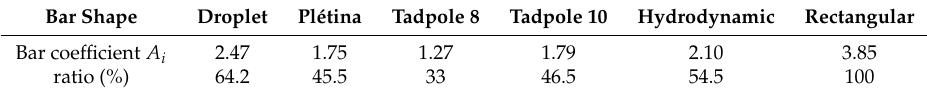
Figure 8. Linear regression of the ξ bars for the four bar shapes (( a ) for Droplet, ( b ) for Plétina, ( c ) for Tadpole 8, ( d ) for Tadpole 10) as a function of the K b × K β . Table 3. Bar shape coefficients of the tested